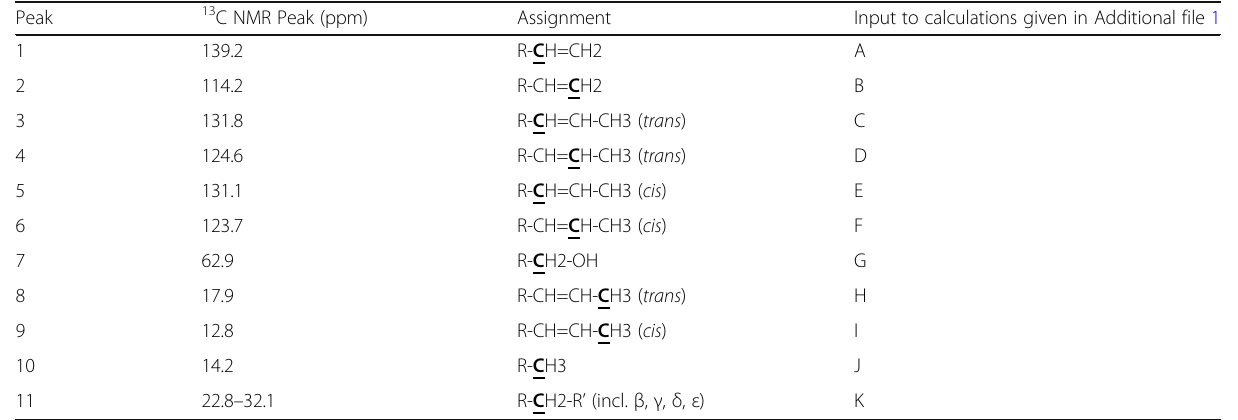
Table 8 13 C NMR Peak assignments